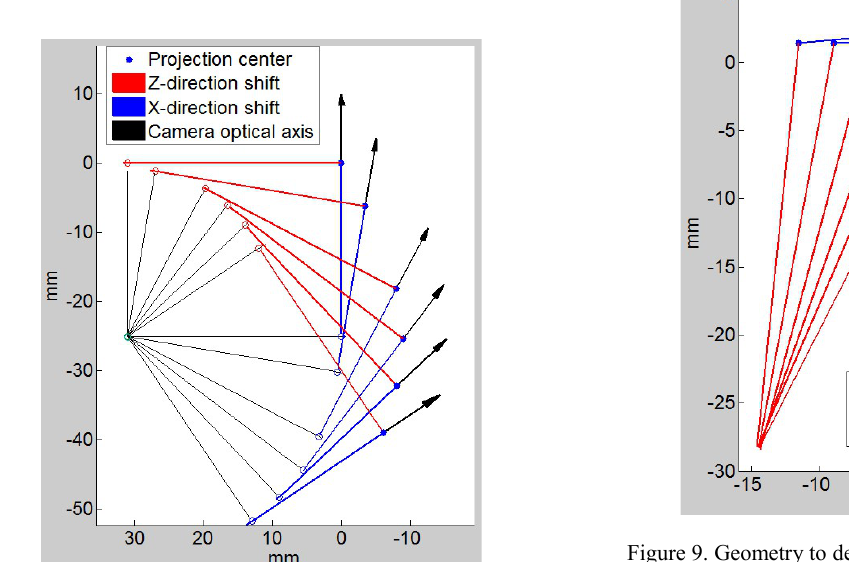
Figure 9. Geometry to determine the Y translation for the concentric imaging in the case of the motorized